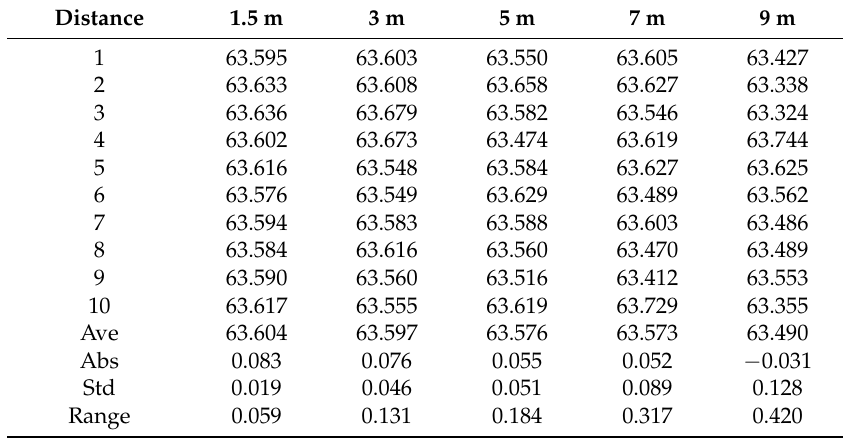
Table 3. Repeatability test for the circle diameter (in mm) measured at different distances.